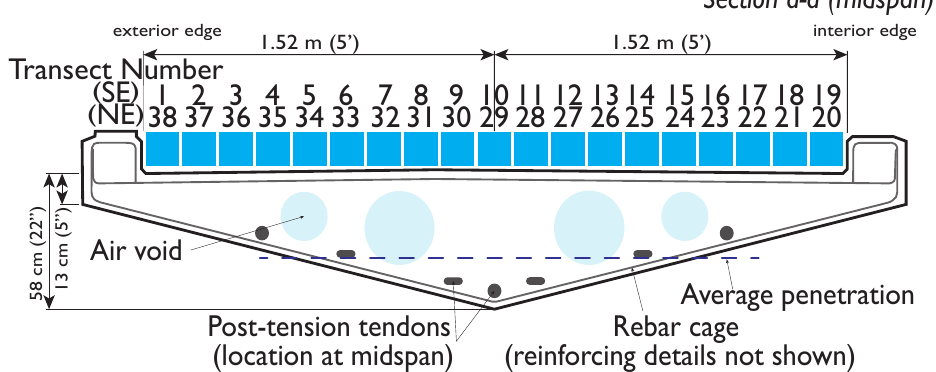
Figure 4. Section a–a taken between columns at midspan (post-tension tendons at their lowest point) showing location of GPR scans relative to internal features. The detailed reinforcing in the section is not included for clarity; only the contour of rebar cage is shown. Transects run longitudinally from the main span down the SE